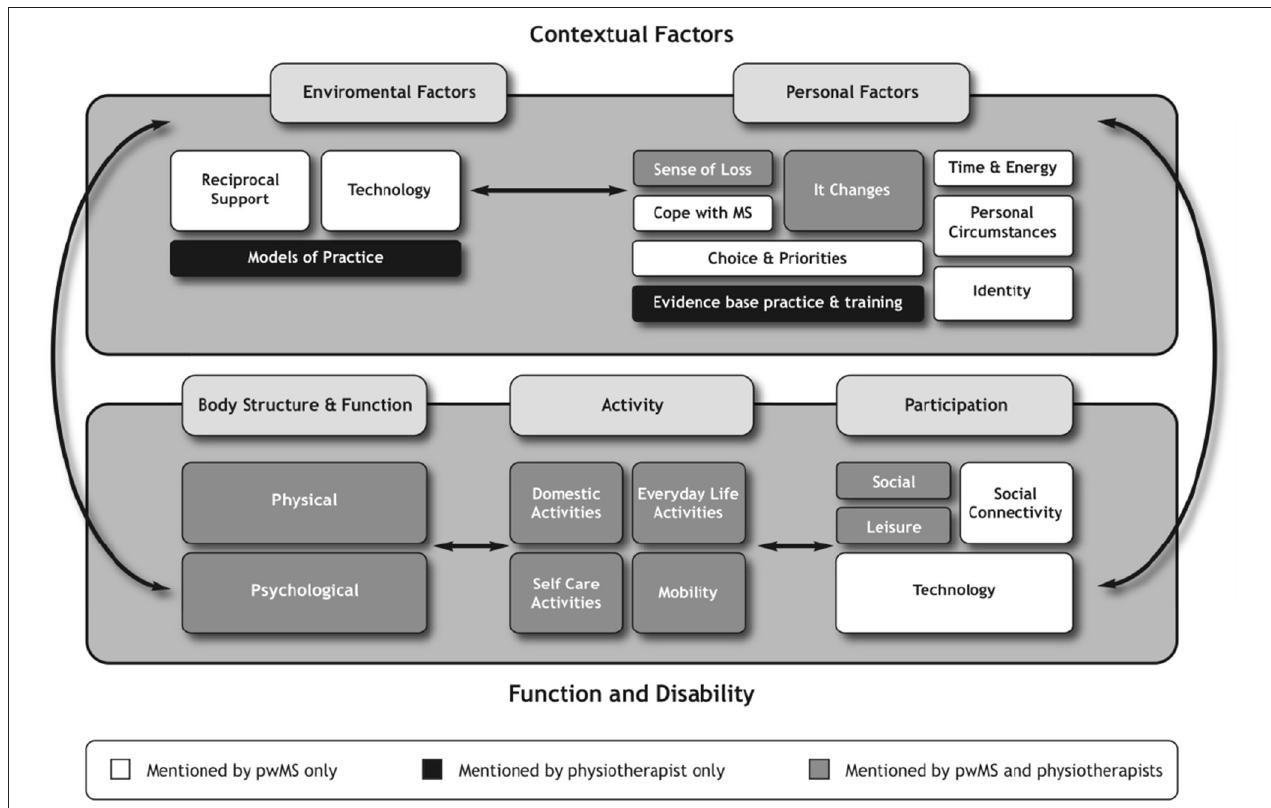
FIGURE 5 | Reorientation of the ICF based on the experiential and perspective of the professionals of exercise and physical activity.